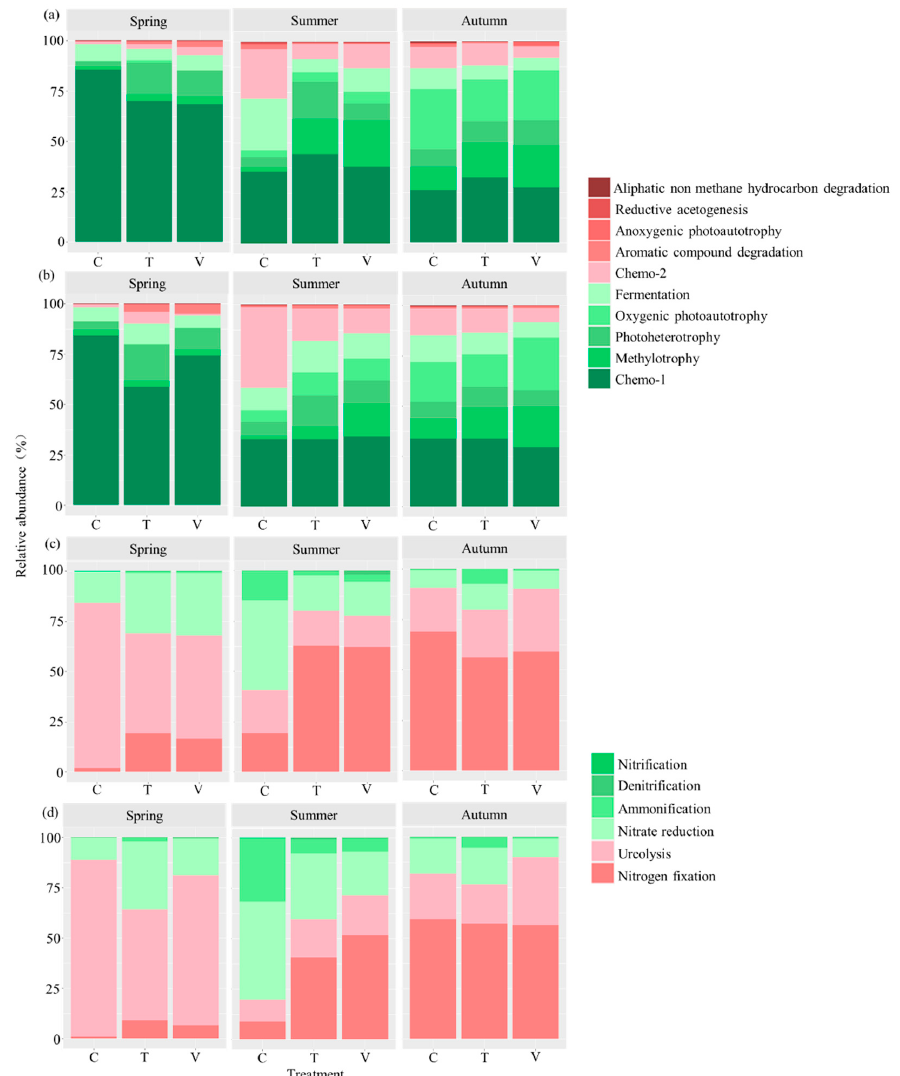
Figure 3. The relative functional abundance of bacteria related to carbon cycle in leaf ( a ) and stem litter ( b ), and the relative functional abundance of bacteria related to the nitrogen cycle in leaf ( c ) and stem litter ( d ).